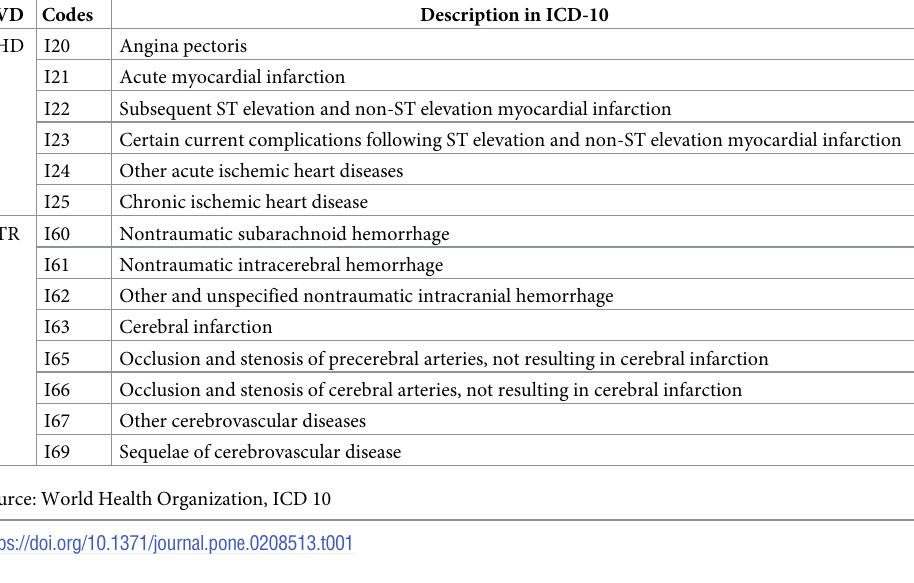
Table 1. Definition of CVD (CHD,STR) using